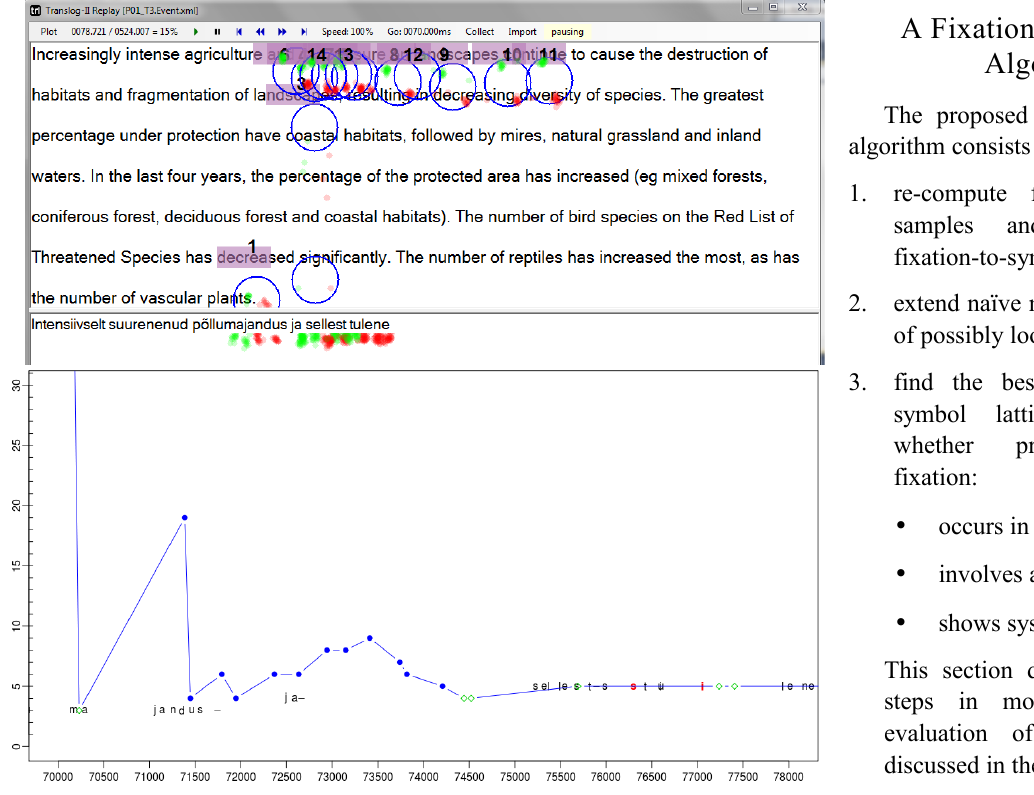
Figur 2: Replay with re-computed fixation-to-symbol mapping showing the 8 second translation segment from Figure 1. Top: the Translog-II replay shows the gaze sample points (red and green), the fixations and fixation to word mapping a line above the map- pings in Figure 1. Bottom: the translation progression graph shows the same segment of time with fixations on the source text (blue) fixations on the target text (green) and key-